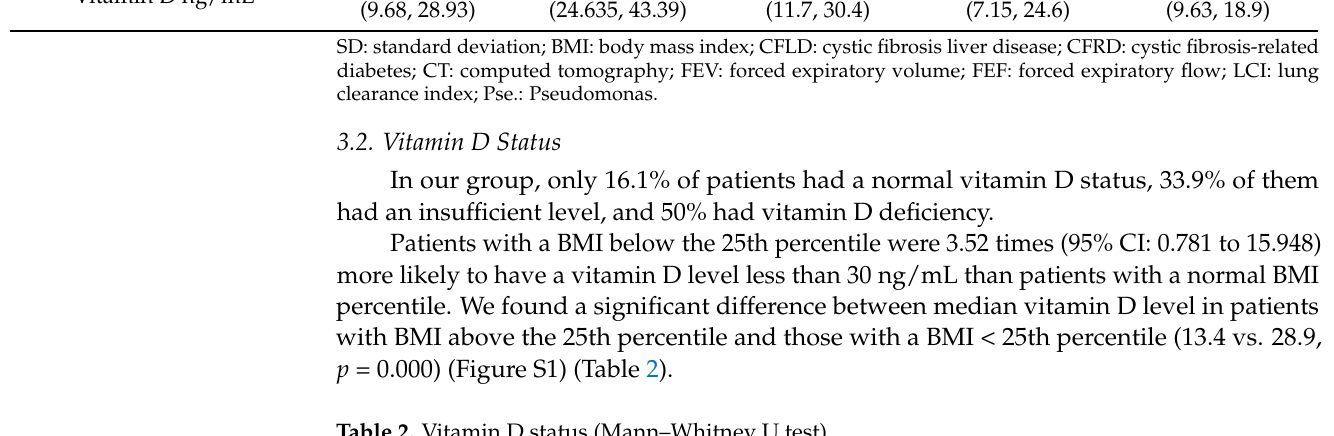
Table 2. Vitamin D status (Mann–Whitney U